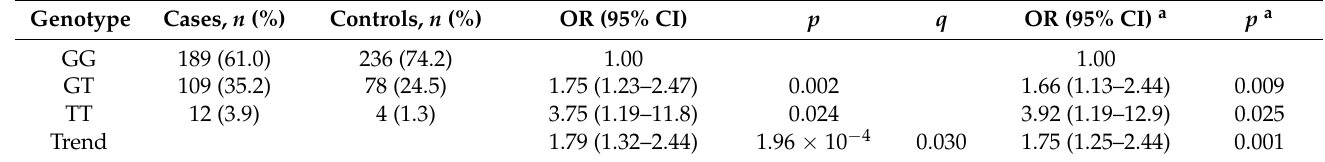
Table 2. The association between SHANK2 rs10792565 and RCC